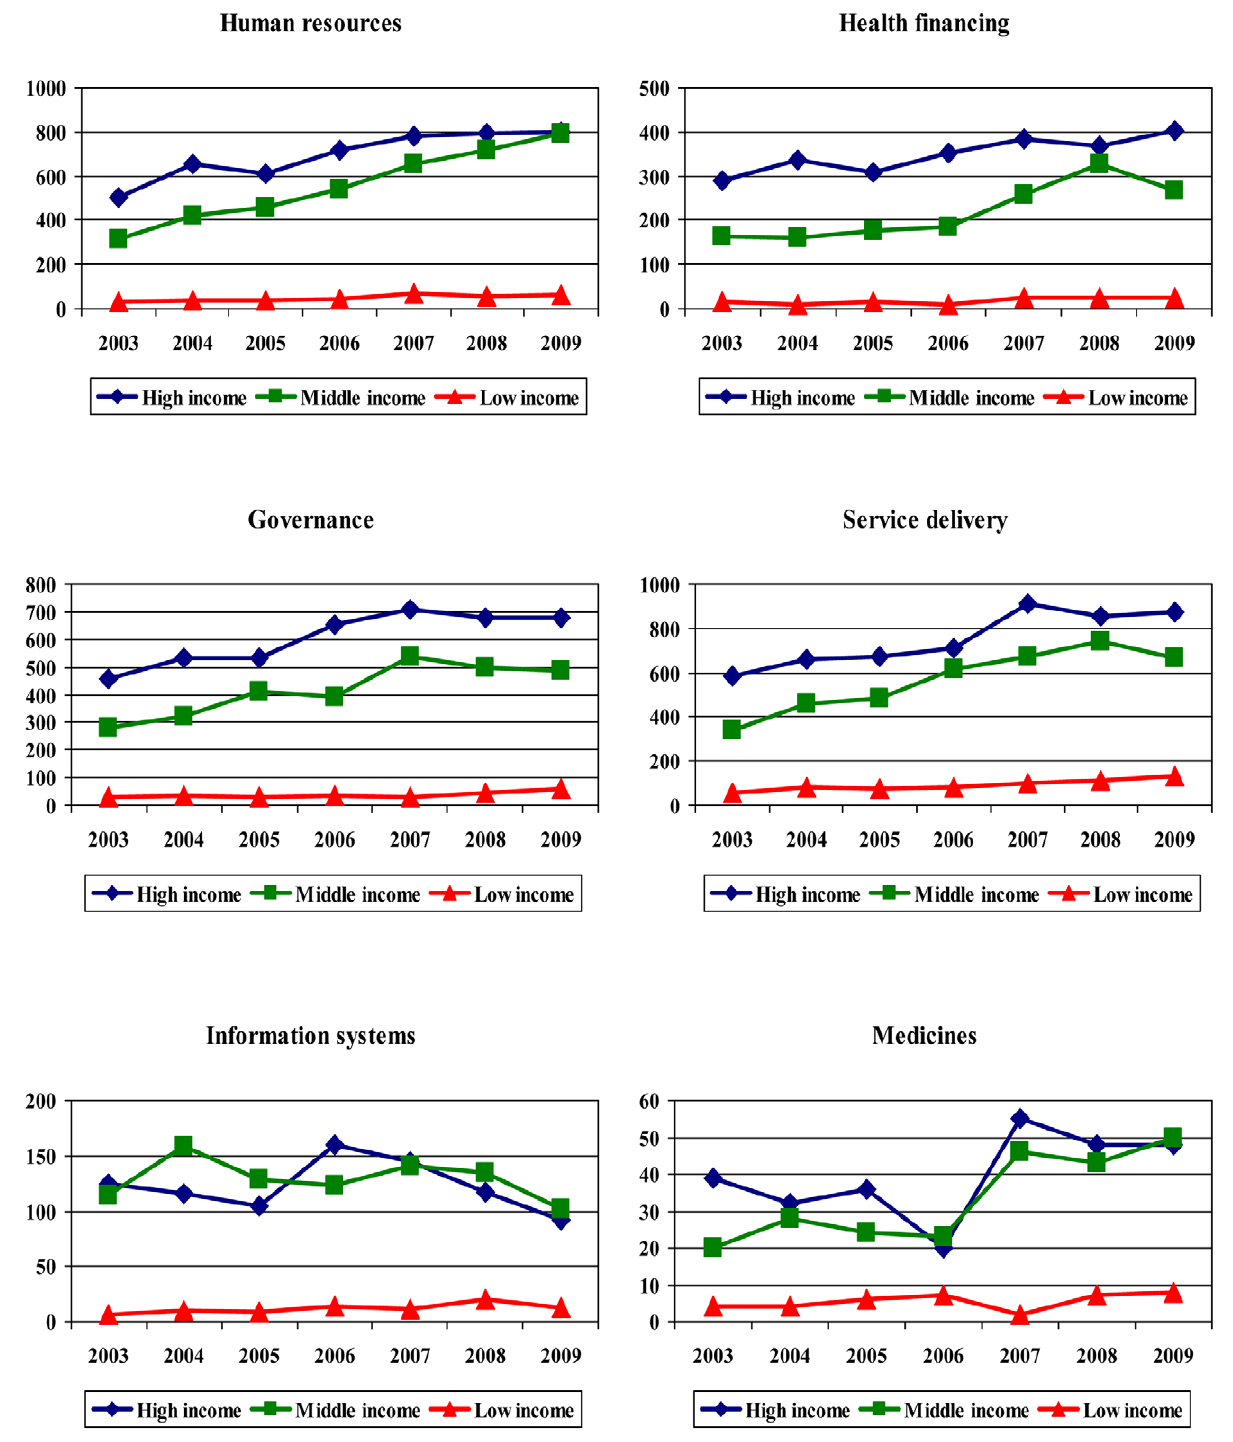
Figure 4. Growth in HPSR publications relevant to LMICs by topic and residence of lead author (2003–2009).